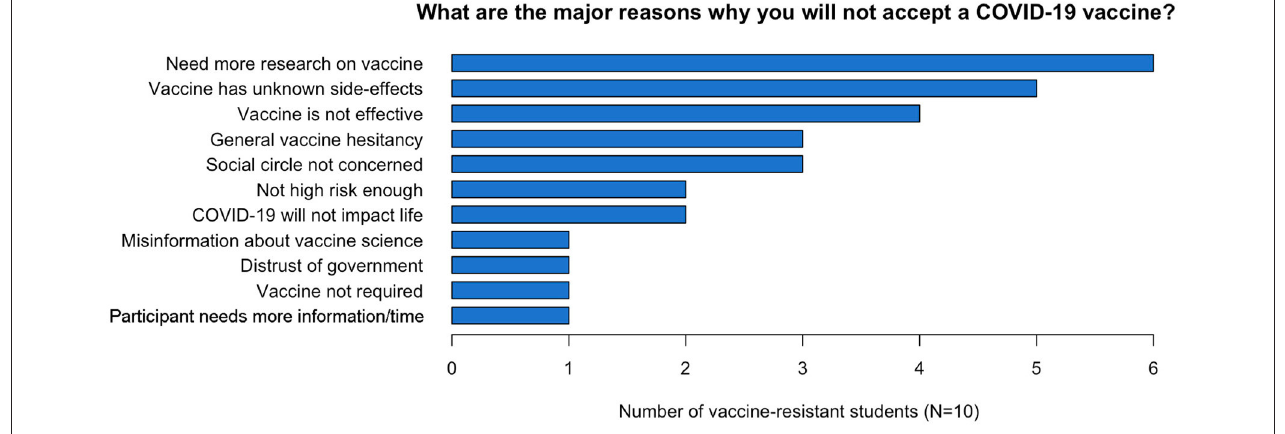
FIGURE 3 | Remaining reasons vaccine-resistant students reject COVID-19 vaccine. Ten post-vaccine awareness respondents who reported not planning to get the vaccine indicated the above reasons for not accepting a COVID-19 vaccine. Ten surveyed respondents answered, “Have you received a COVID-19 vaccine, or do you intend to get a COVID-19 vaccine?” in the post-vaccine awareness questionnaire with “I do not plan to.” The following were the top three remaining reasons why students reported rejecting the vaccines: need for more research (6 of 10), vaccine side effects being unknown (5 of 10), vaccine is ineffective (4 of